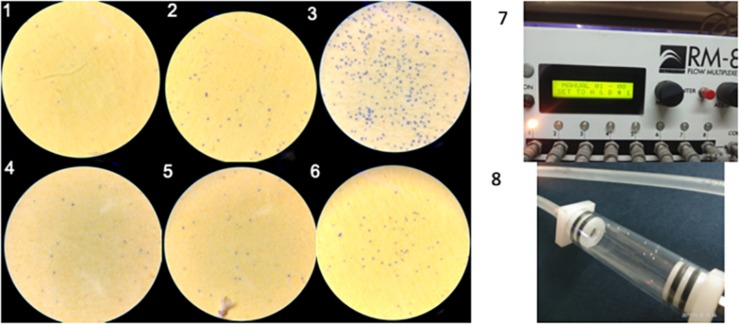
(1–3) Water spots calculated in AQP + dsRNAses knockdown ts 0.039 spots/mm2, AQP knockdown is 0.08 spots/mm2 as compared to GFP control is 0.25 spots/mm2, respectively. (4–6) water spots calculated in CAL + dsRNAses knockdown is 0.03 spots/mm2, CAL knockdown is 0.08 spots/mm2 as compared to GFP control is 0.16 spots/mm2, respectively. (7) Water vapor analyzer (RM-S flow multiplexer) to study water loss from the whitefly. (8) whitefly released in the channel of RM-8 flow multiplexer to estimate water loss.